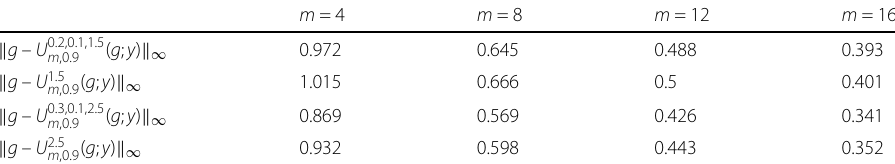
Table 1 Comparison of operators with maximum errors m = 4 m = 8 m = 12 m = 16